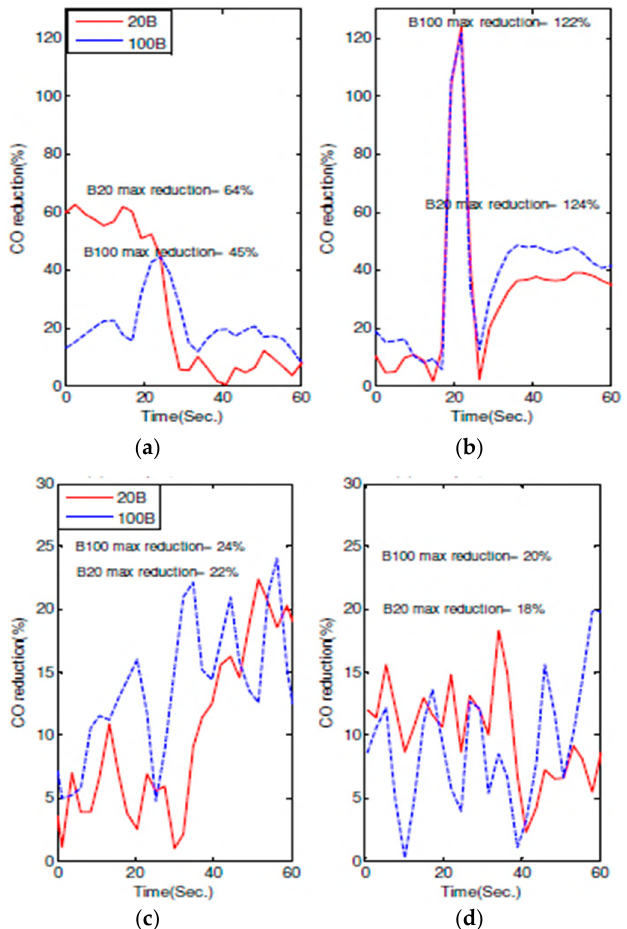
Figure 17. Time variation of percentage CO emissions reduction in the engine running 20B and 100B during the ( a ) positive and ( b ) negative speed transient at a torque of 420 Nm. Percentage CO emission reduction over time with 20B and 100B at 1500 rpm during the ( c ) positive and ( d ) negative torque transient.